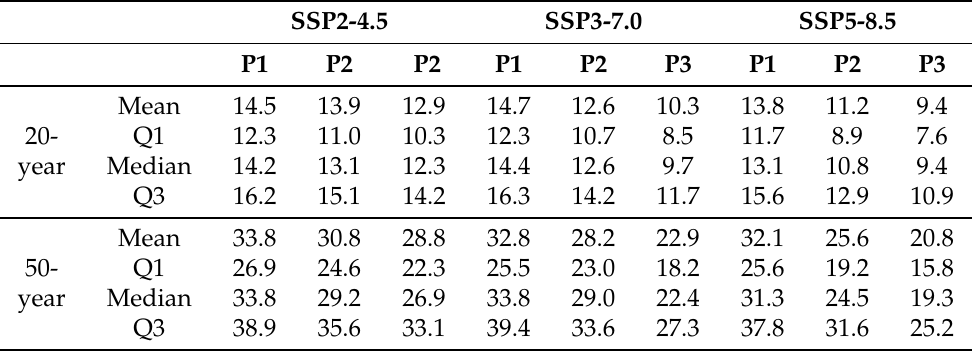
Table 2. Statistics of 20-year and 50-year return periods (unit: year) of the annual largest daily rainfall averaged over 47 grids in the Iran for future periods P1 (2021–2050), P2 (2046–2075), and P3 (2071–2100) under the SSP2-4.5, SSP3-7.0, and SSP5-8.5 scenarios.